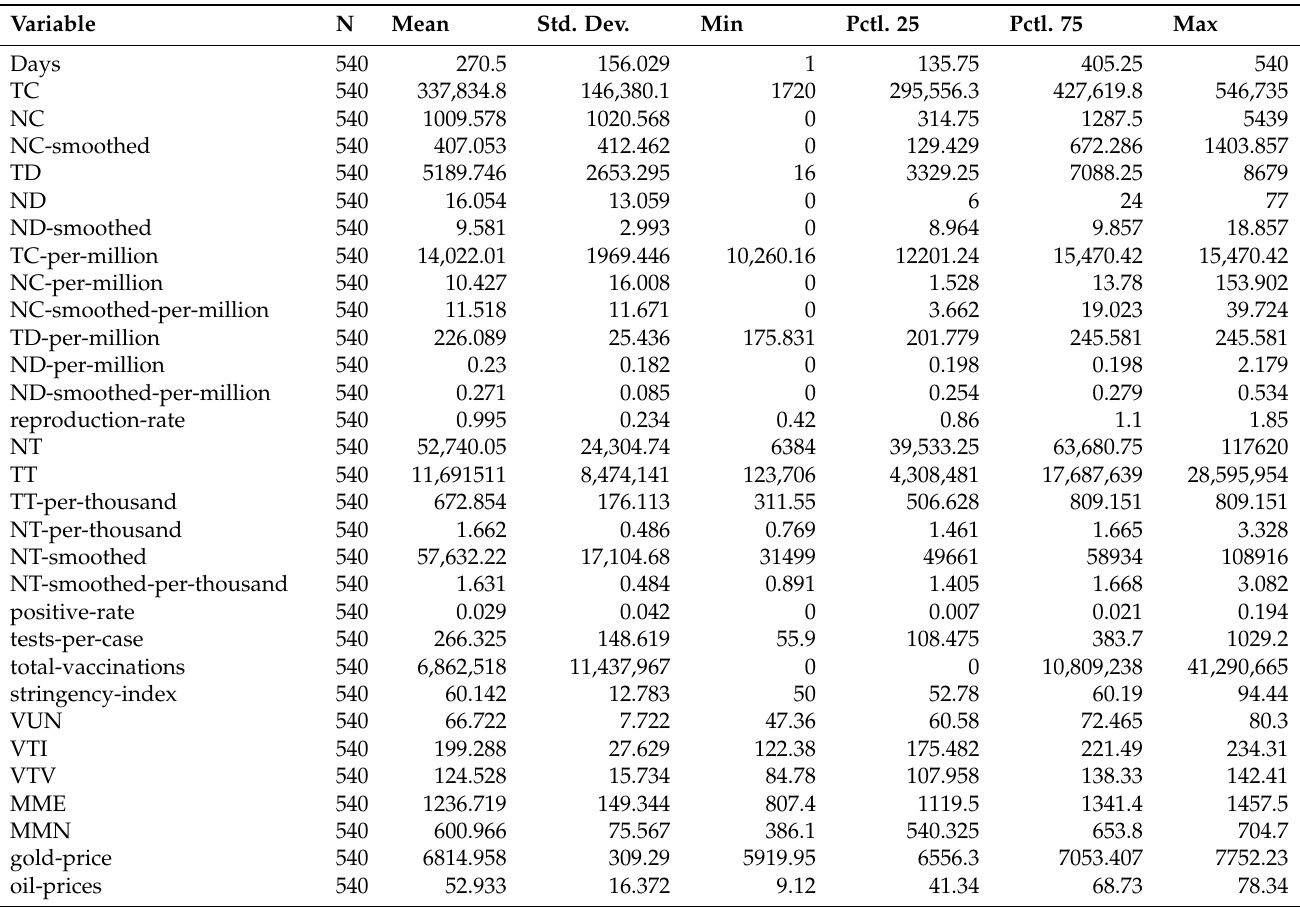
Figure 2. Plots of the total number of vaccinations versus the day count ( a ) with the 43 missing data points, ( b ) after imputing the missing values using the Growth Interpolation technique. Table 1. Statistical summary of the integrated